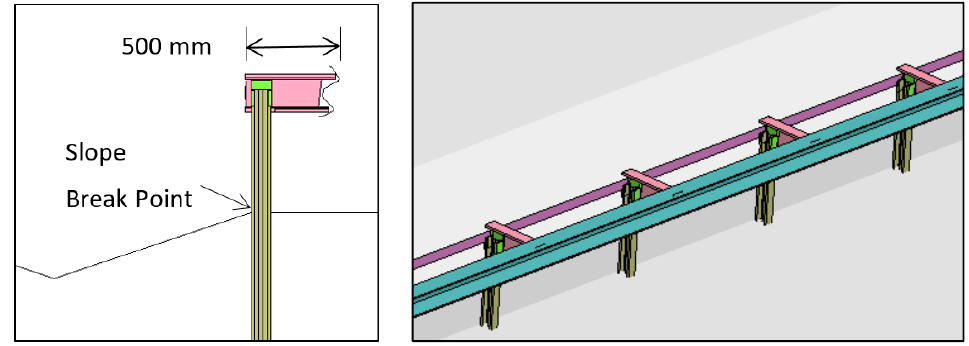
Figure 6. Finite element model of a steel EDSP-1.33 barrier installed at a slope break point of a ditch.